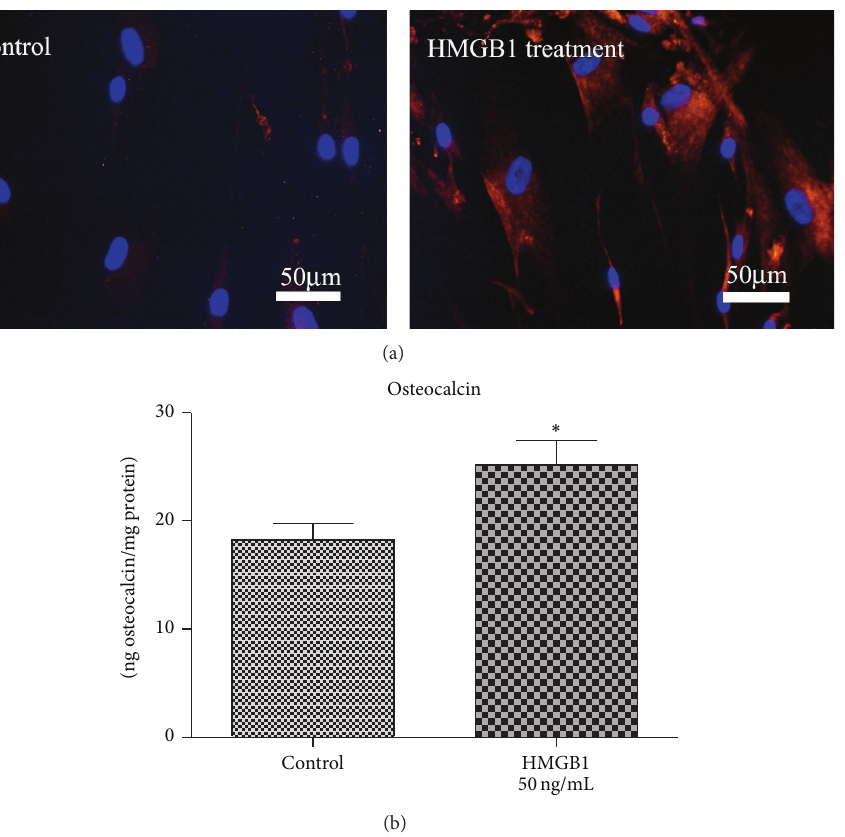
Figure 5: HMGB1 upregulates osteocalcin protein expression. In addition later stages of maturation were also affected by HMGB1. Enhanced osteocalcin protein expression was demonstrated, both in immunofluorescent stainings and by osteocalcin ELISA. Data represent the mean ± SD for six independent cultures. ∗ 𝑃 < 0.05 , experimental group versus untreated